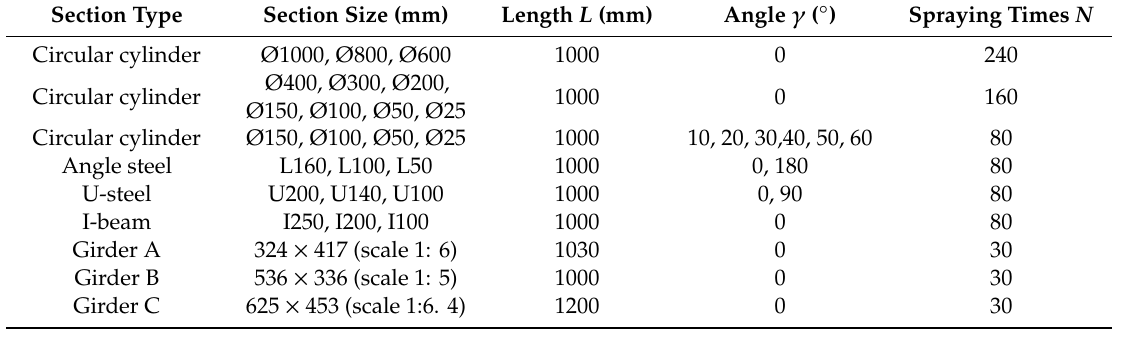
Table 1. Summary of icing test cases.